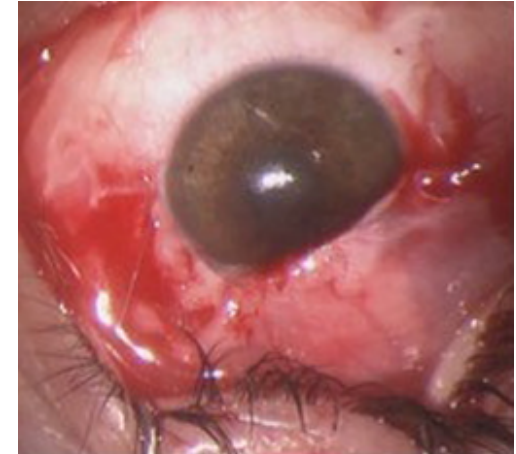
Figure 6: Conjunctiva over the graft